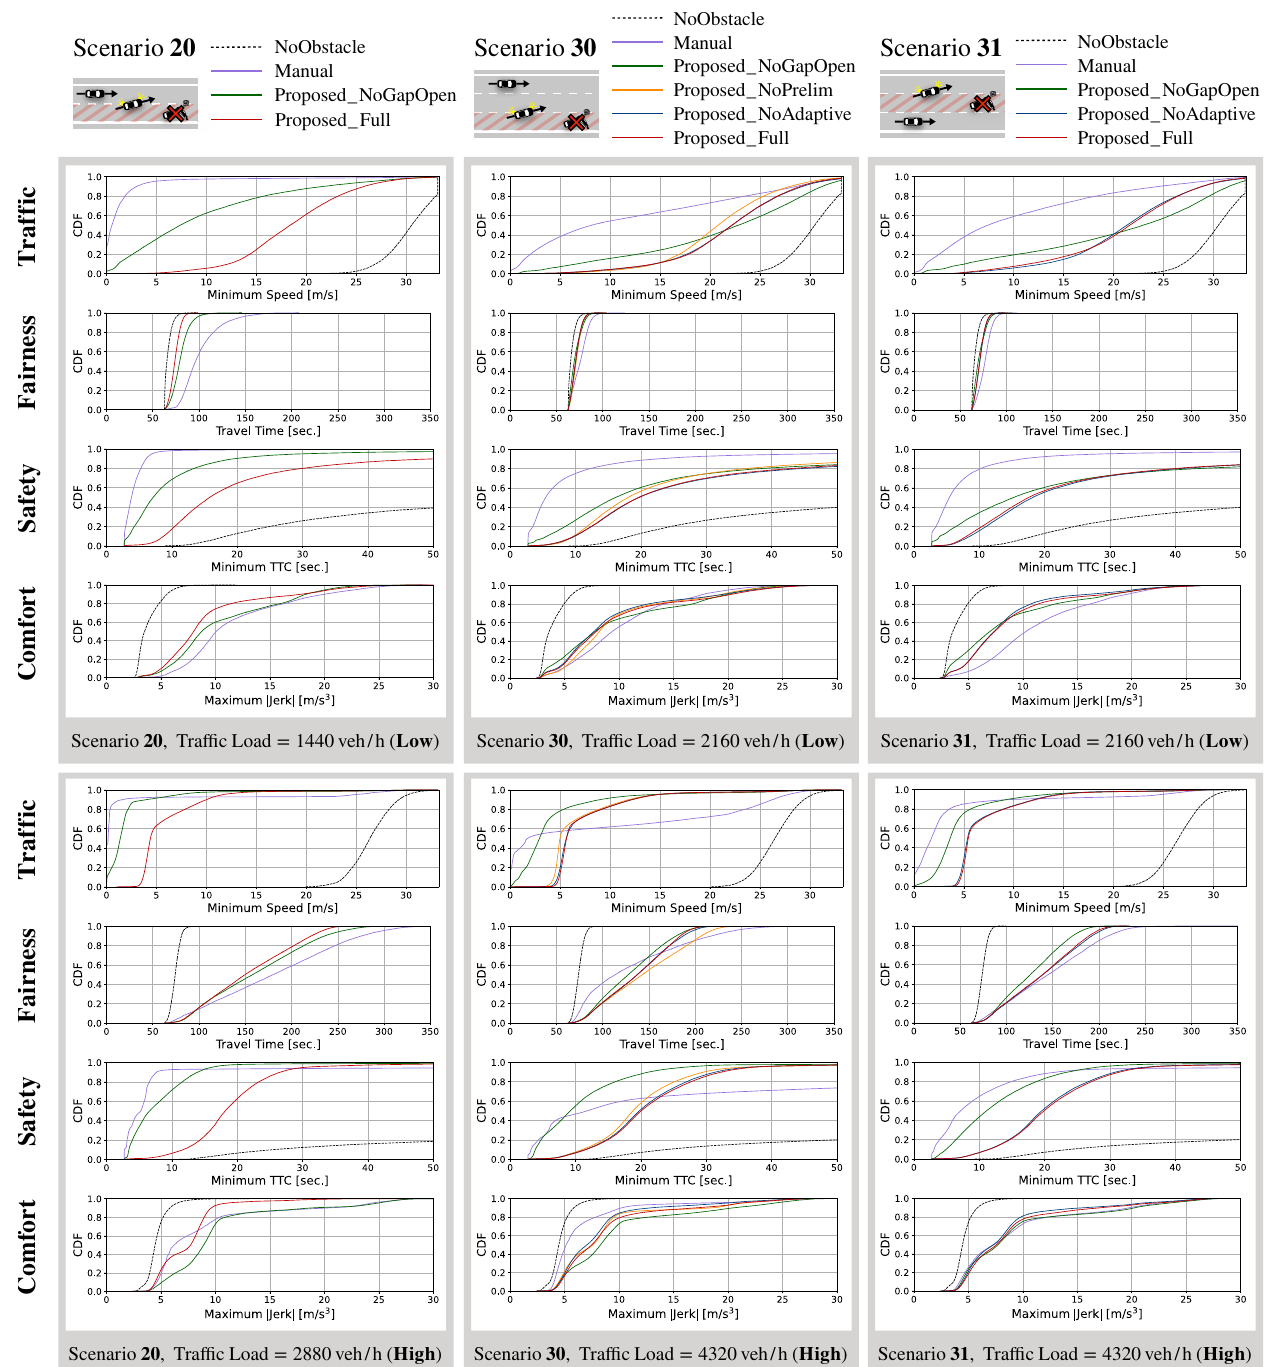
Figure 8. Simulation results for each vehicle behavior model under fixed traffic loads, d avoid = 300m, d prelim = 100m, d decel = 500m, CV penetration ratio =